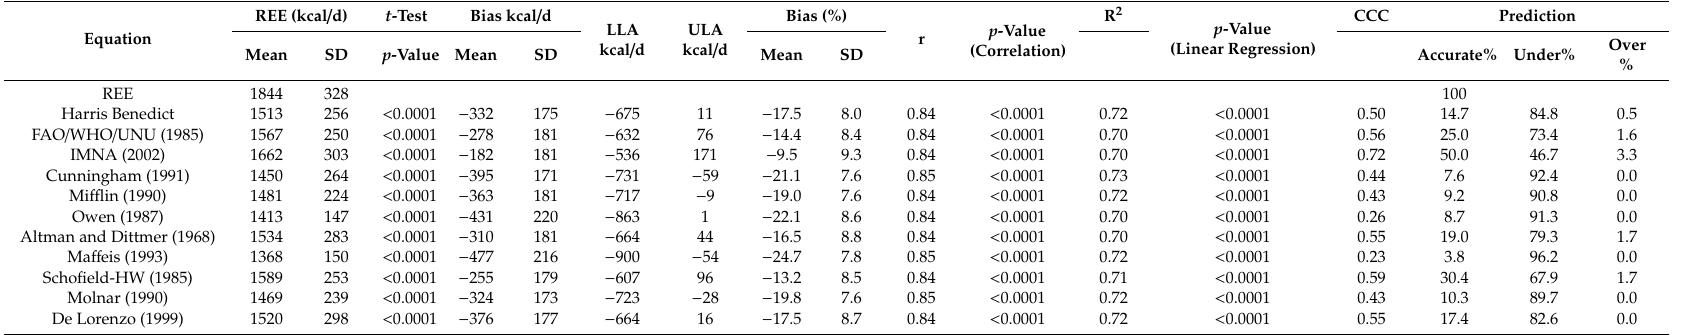
Table 2. Validity of resting energy